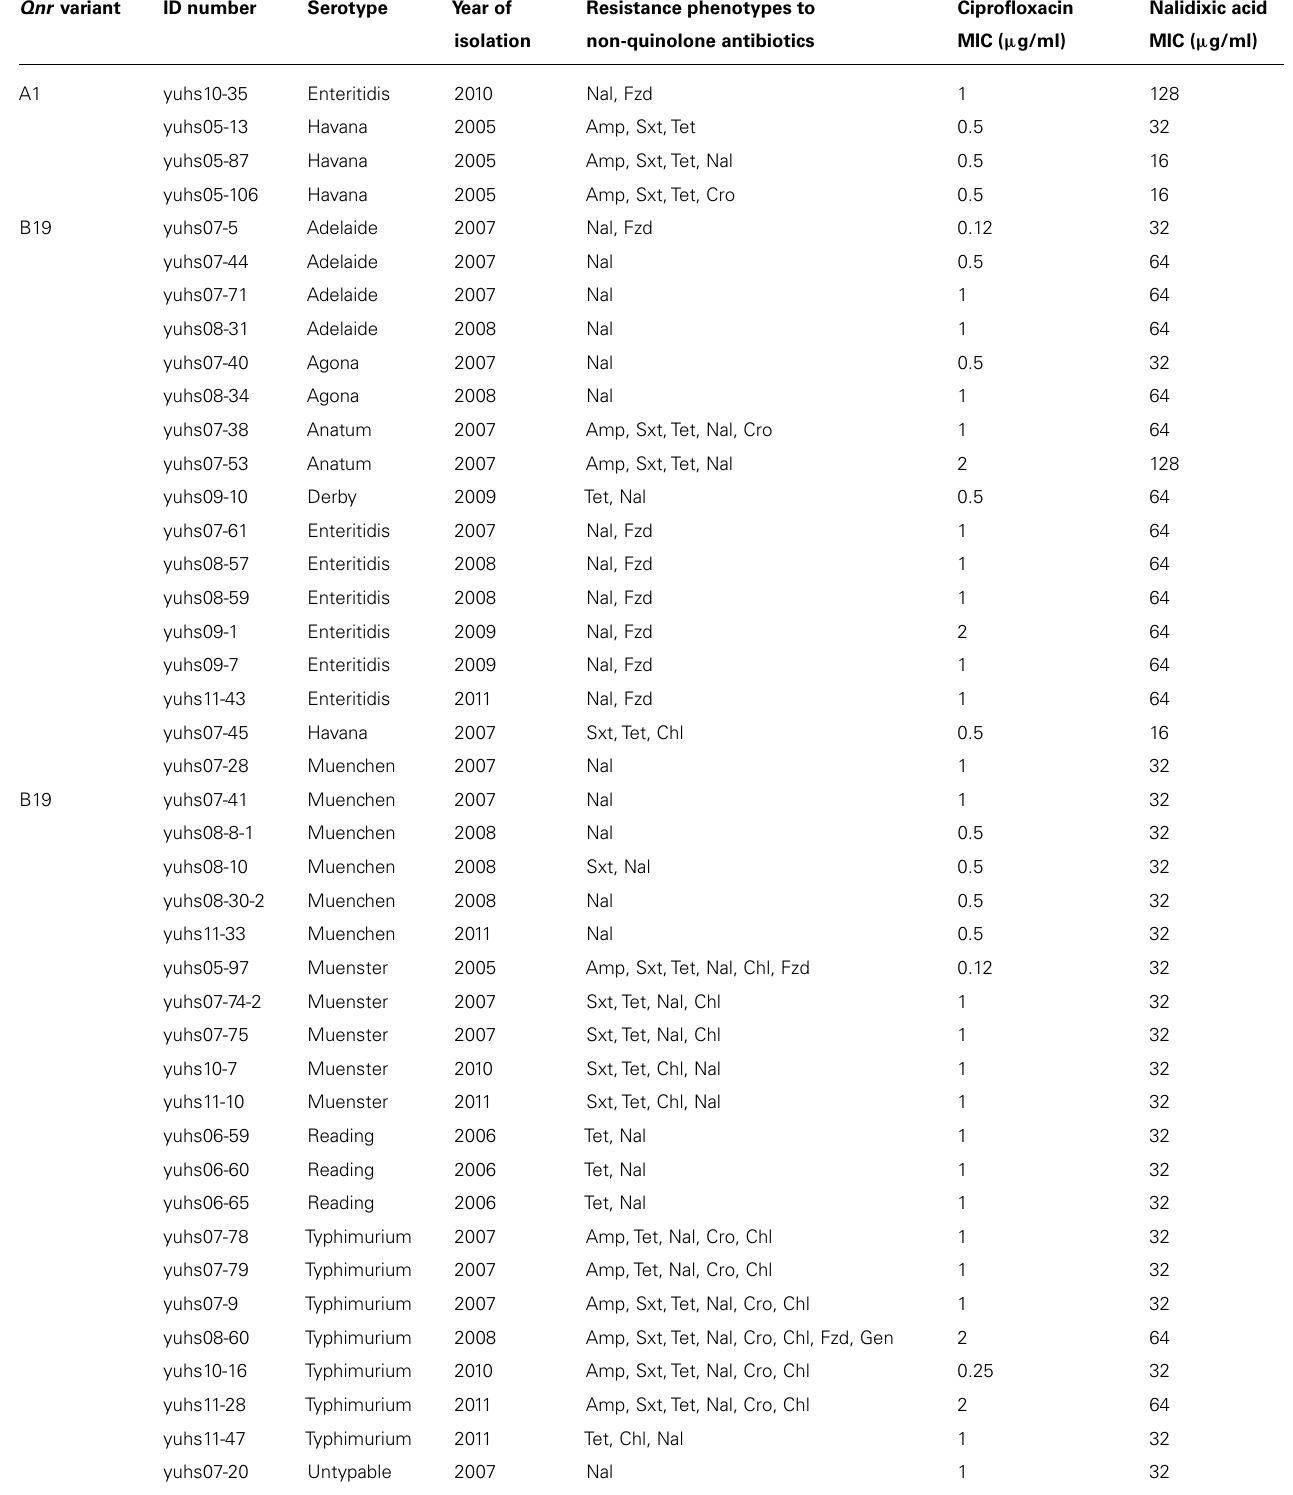
Table 4 | Serotype distribution and antimicrobial susceptibility of Salmonella isolates positive for the qnr gene,Yucatan, Mexico, 2005–2011. Qnr